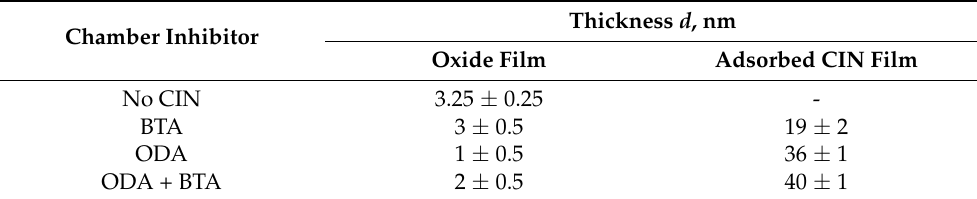
Table 10. Effect of brass chamber treatment on the surface film thickness. T CT = 120 ◦ C, and τ CT = 60